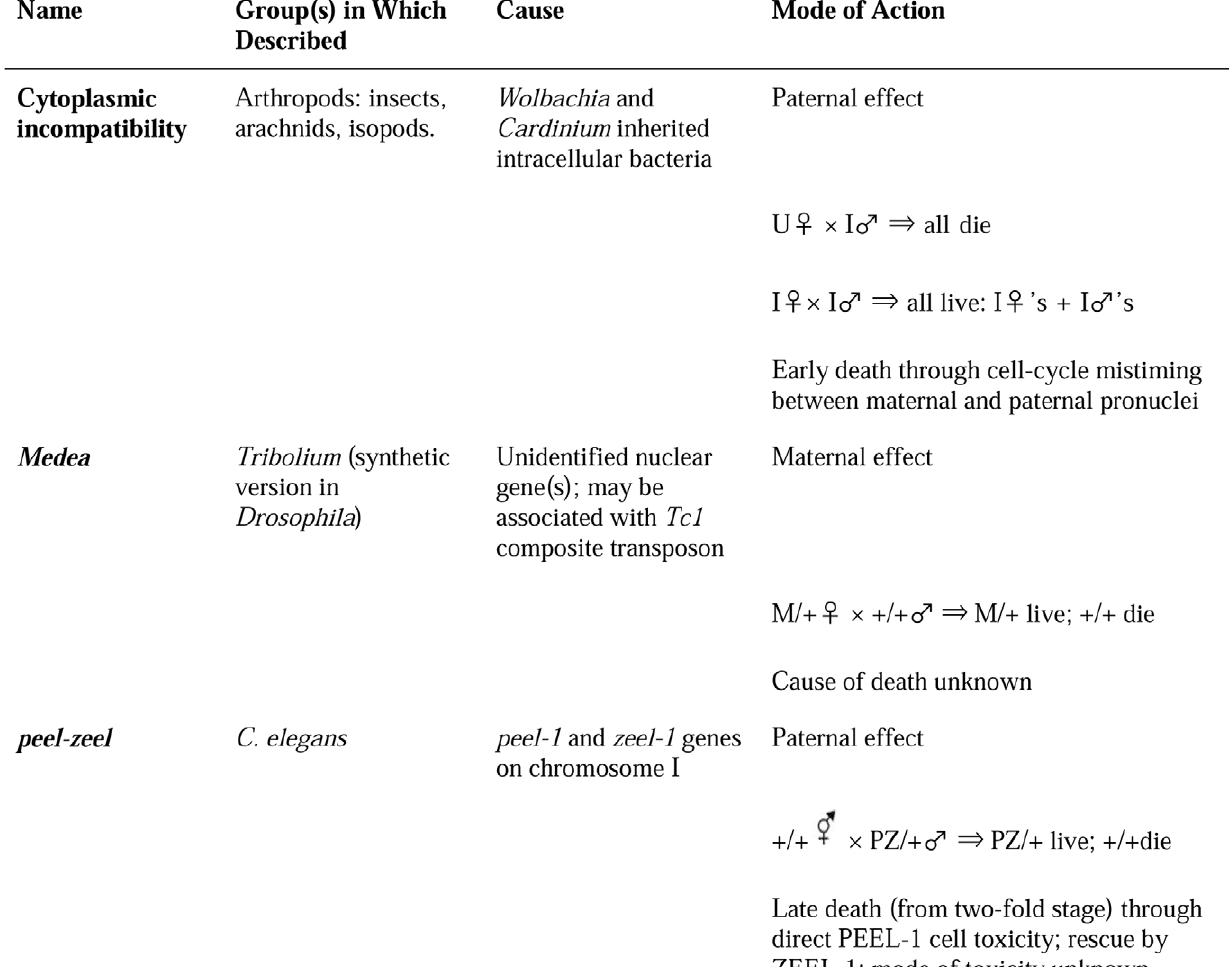
Figure 1. Embryo killer systems in invertebrates. I, infected; U, uninfected.